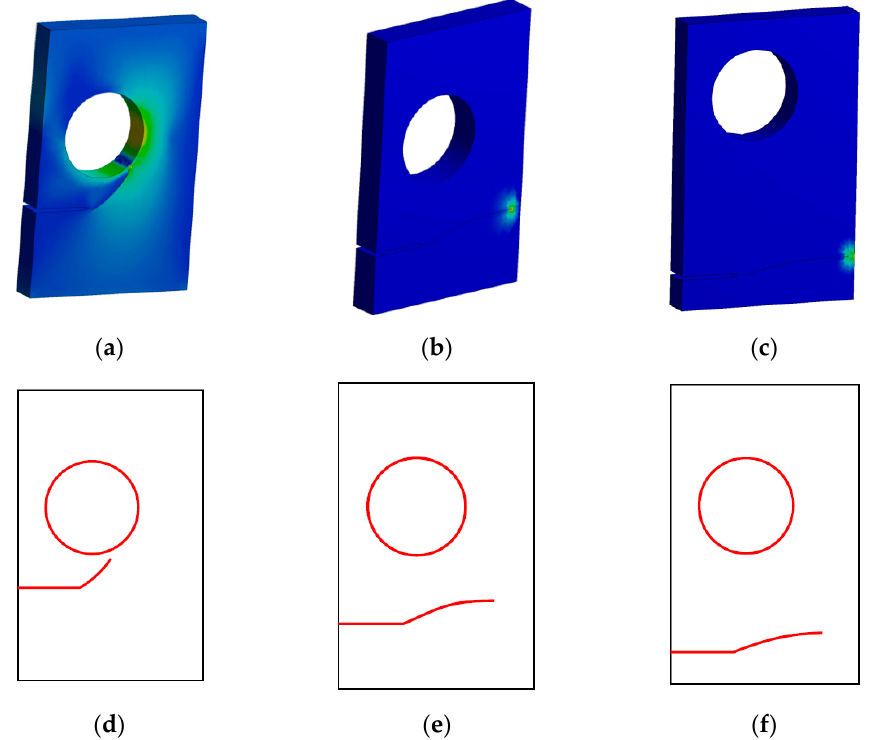
Figure 12. Crack growth trajectories, ( a ) h = 15, ( b ) h = 10, ( c ) h = 5, ( d ) h = 15 [41] , ( e ) h = 10 [41] , and ( f ) h = 5 [41] .